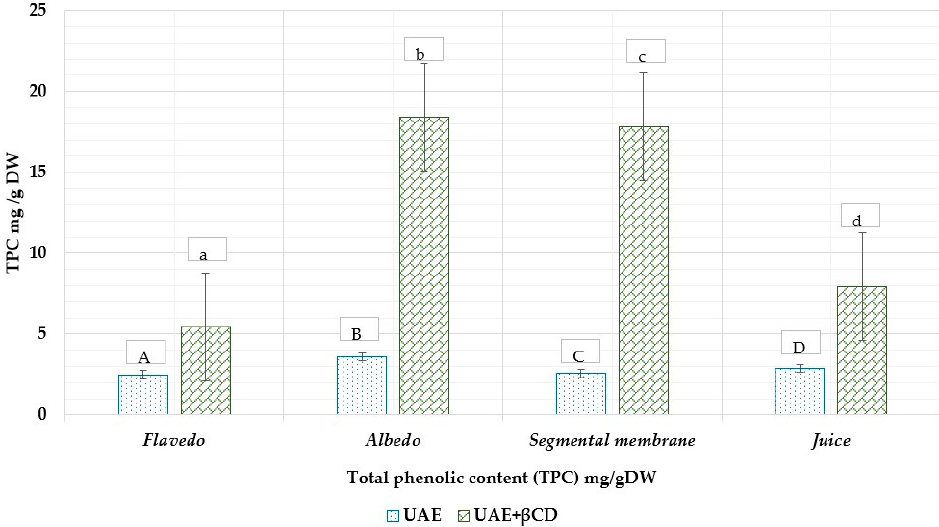
Figure 12. The total phenolic content TPC in grapefruit ethanolic extract with and without β -CDs. A, B, C, D—ultrasound extraction method (UAE), a, b, c, d—ultrasound extraction method (UAE) + β -CDs. The result is the mean value ( n = 3) a, b, c, d p < 0.05 vs. A, B, C, D.